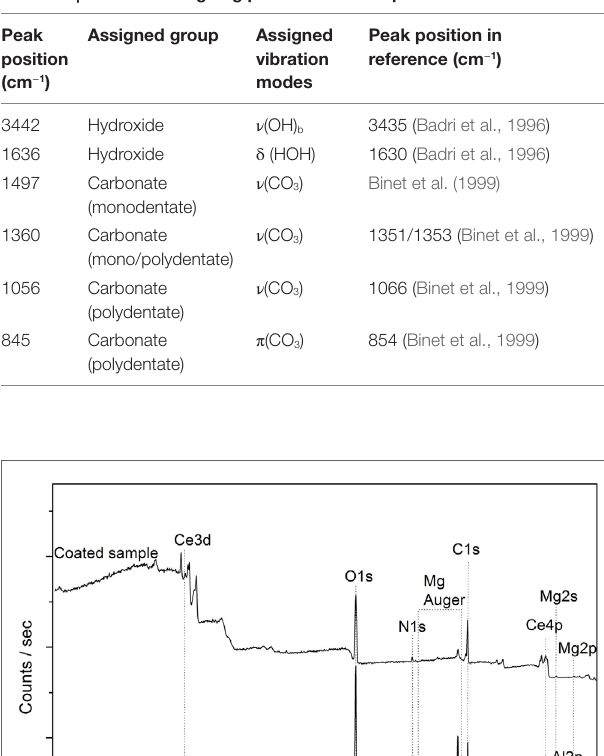
TaBle 1 | relevant assigning peaks of irras spectra.